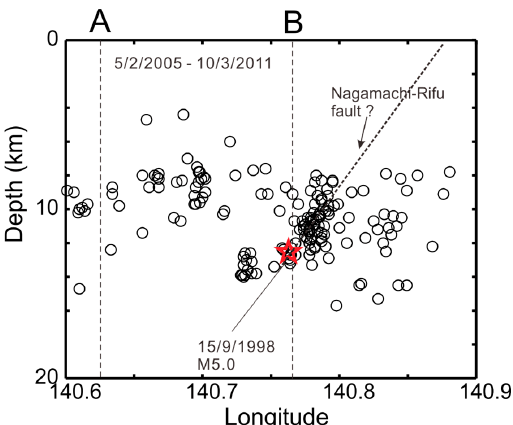
Figure 2. Vertical cross section showing hypocenters of micro-earthquakes before the Tohoku earthquake projected onto the vertical plane defined by line A–B (location in Figure 1b). The dashed line shows the downward projection of the Nagamachi-Rifu fault. The red star represents the source location of the earthquake of magnitude (M) 5.0 occurred on 15 September 1998.